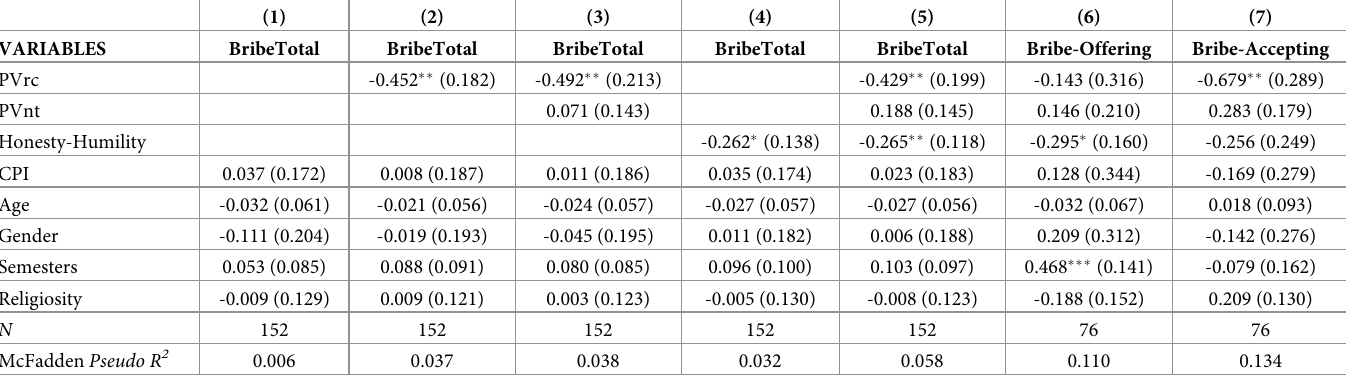
Table 3. Probit analyses of engagement in